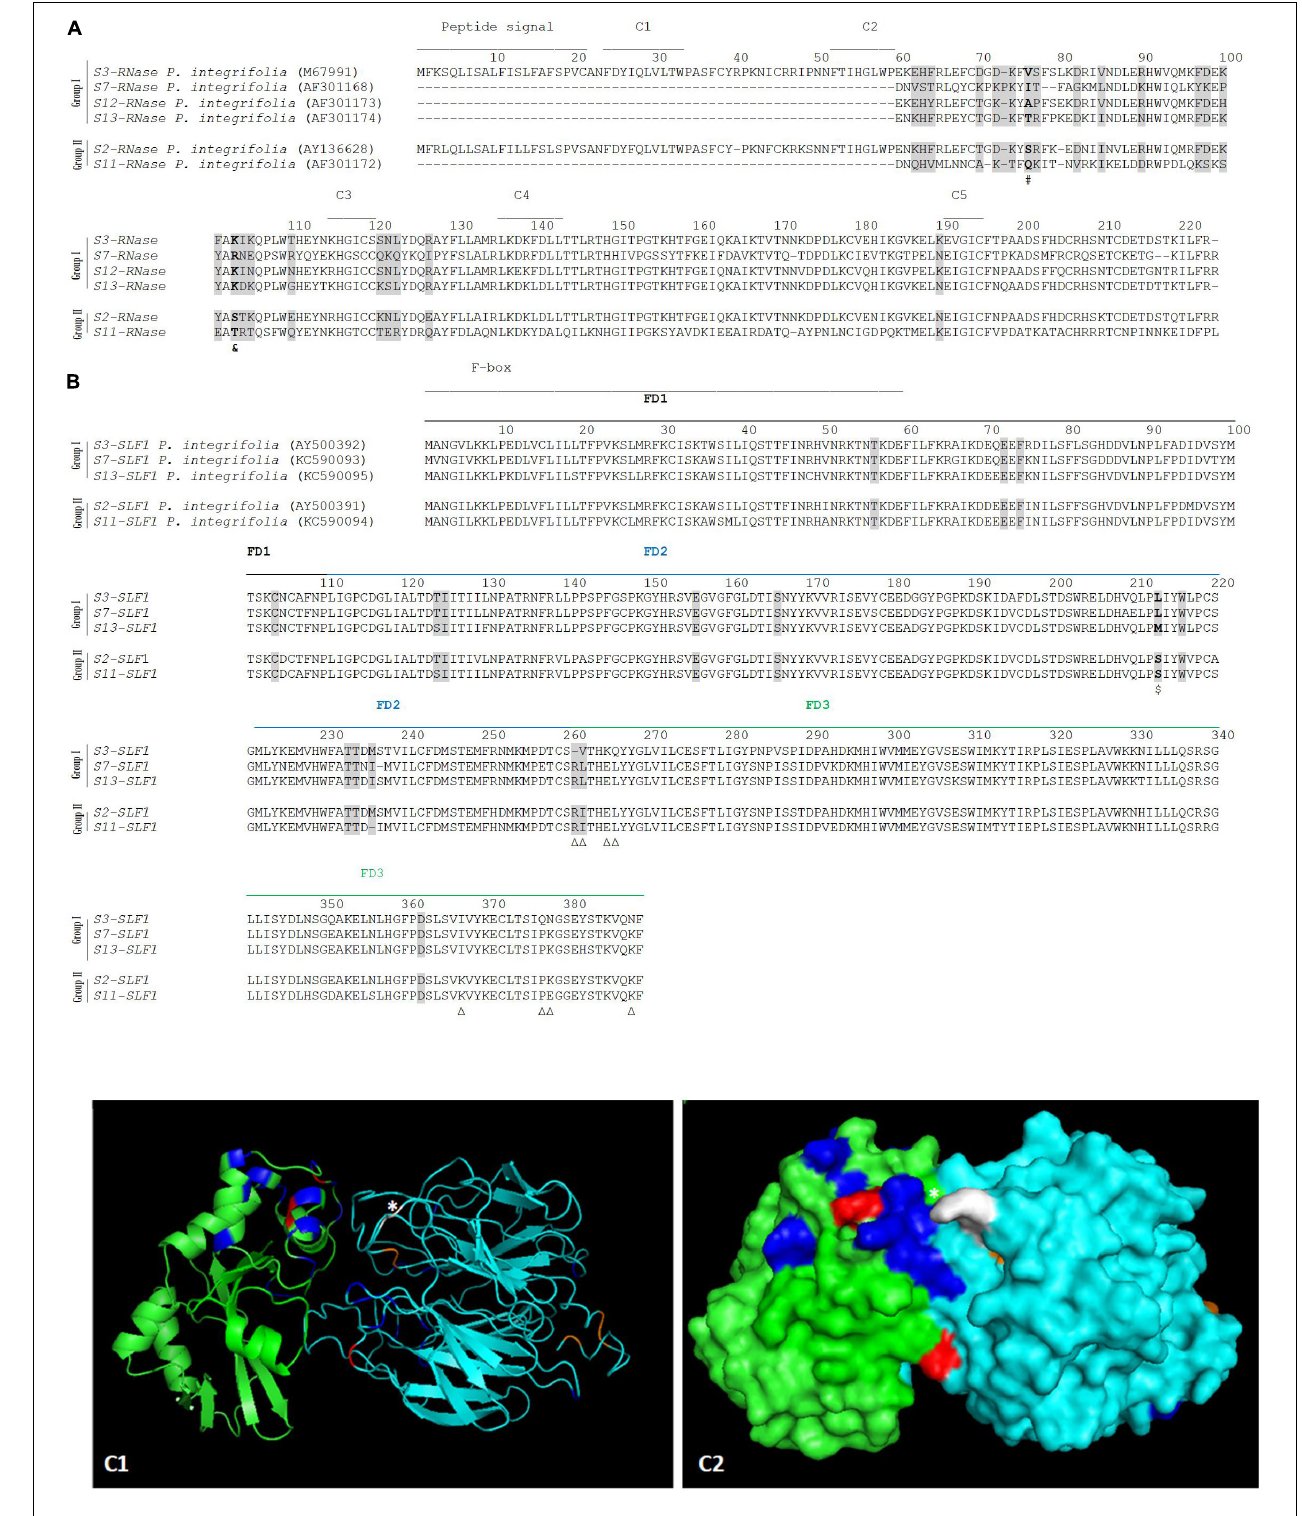
FIGURE 2 | Positively selected amino acid sites in the S-RNase (A) , SLF1 (B) alignments (highlighted in gray), and in the predicted docking structure of P. integrifolia S3-RNase/S2-SLF1 (as cartoon C1, and surface C2) predicted to be involved in recognition of S3-, S7-, S12-, and S13-RNases (group I) as non-self, and S2- , and S11-RNases (group II) as self by the S2-SLF1 and S11-SLF1. (A) The signal peptide and conserved regions (C1- C5) are marked. The amino acid sites marked in